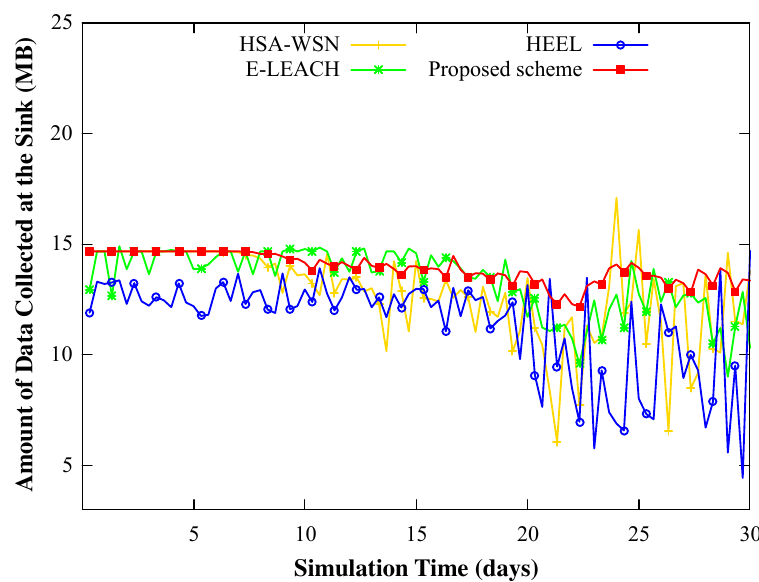
Figure 8. The change in the amount of data sensed during 30 days when simulating with 1600 nodes (21–22th: rainy, 26–27th: cloudy, and other: sunny).